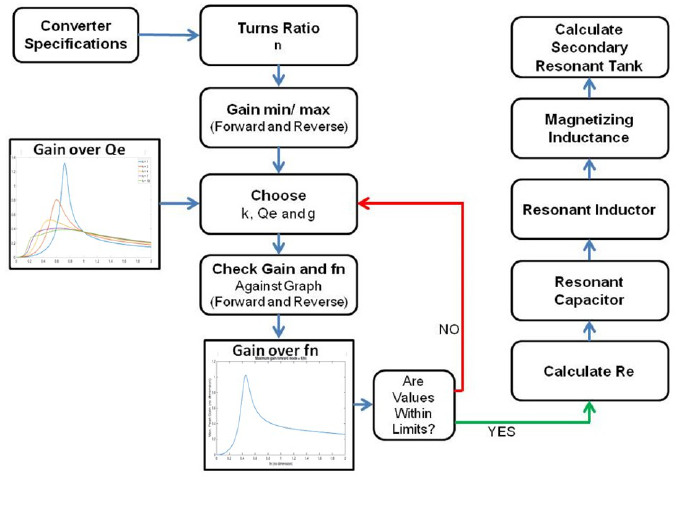
Figure 12. Iterative design flowchart of the CLLC converter